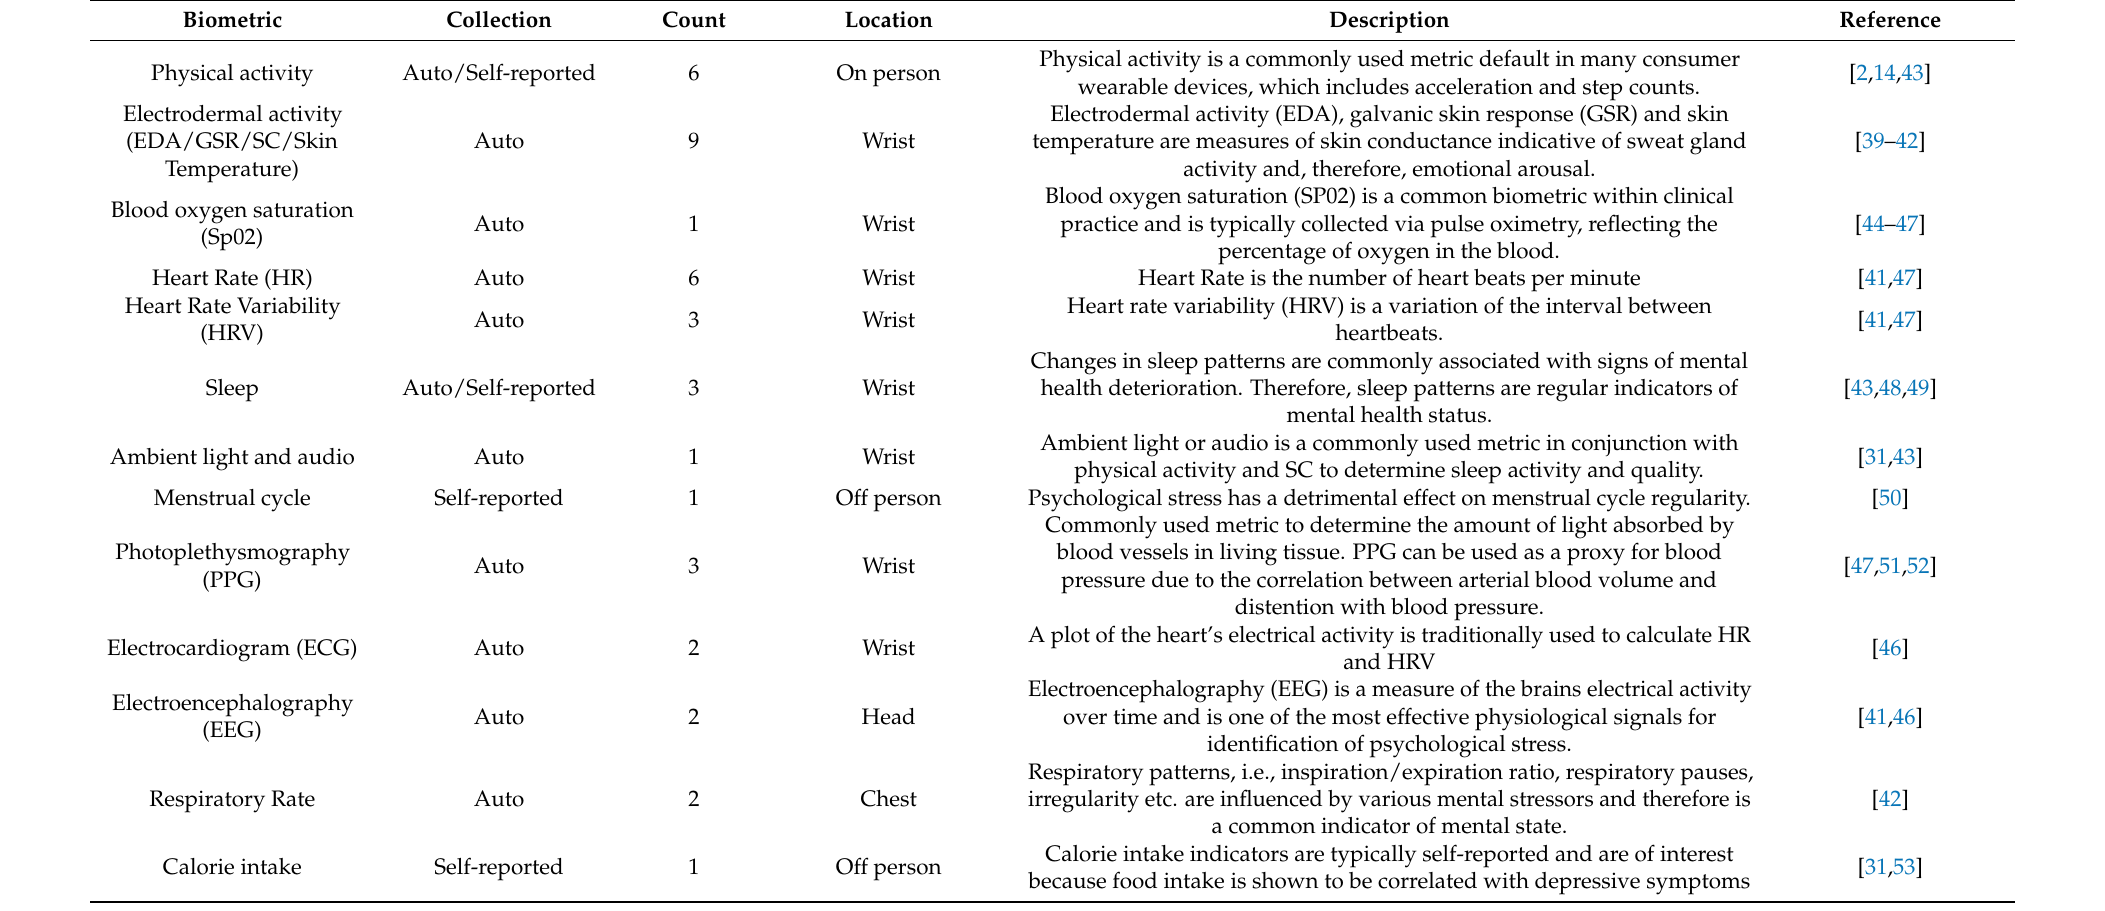
Table 5. Biometrics reference count and